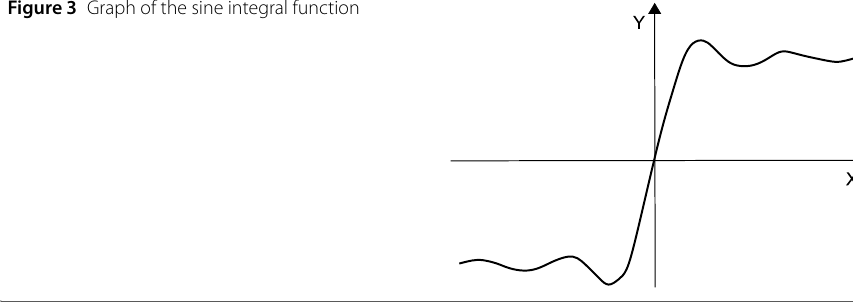
Figure 3 Graph of the sine integral